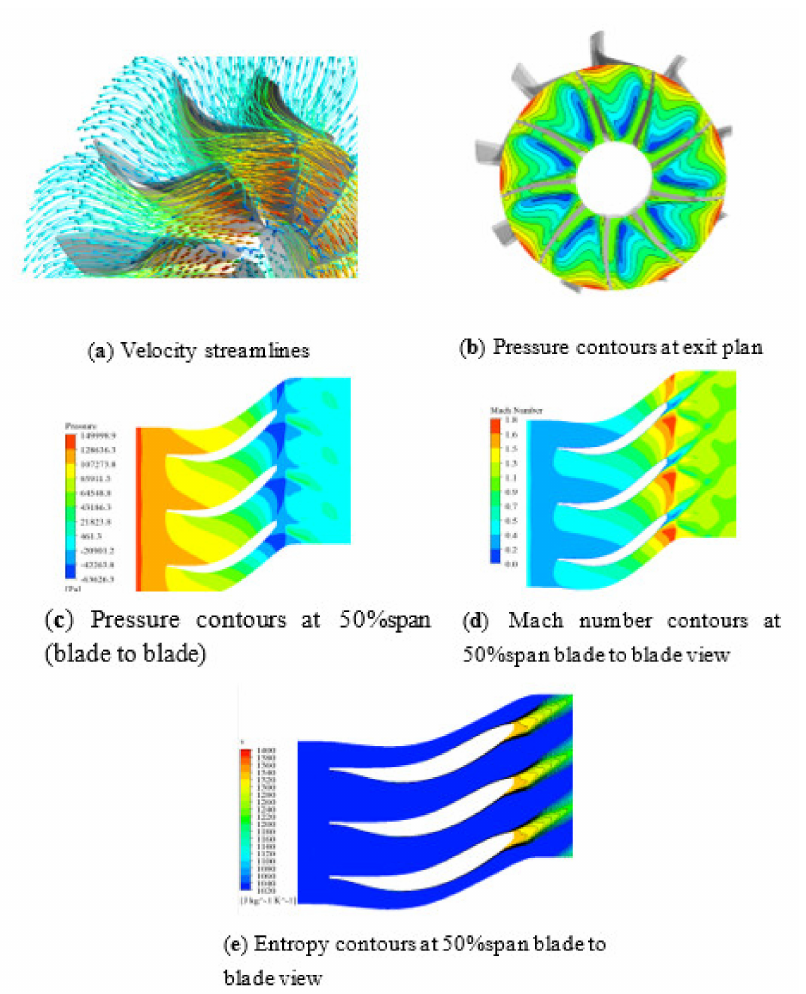
Figure 18. ( a ) Velocity streamlines in the turbine passage, ( b ) pressure contours at the exit plane, ( c ) pressure contours at 50%span (blade to blade), ( d ) Mach number contours at 50%span blade to blade view, ( e ) Entropy contours at 50%span blade to blade